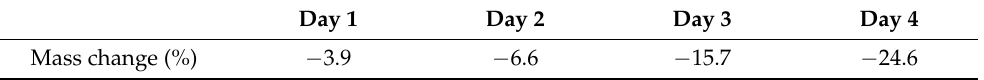
Table 3. Mass changes (%) of examined coatings, during the acid spraying test